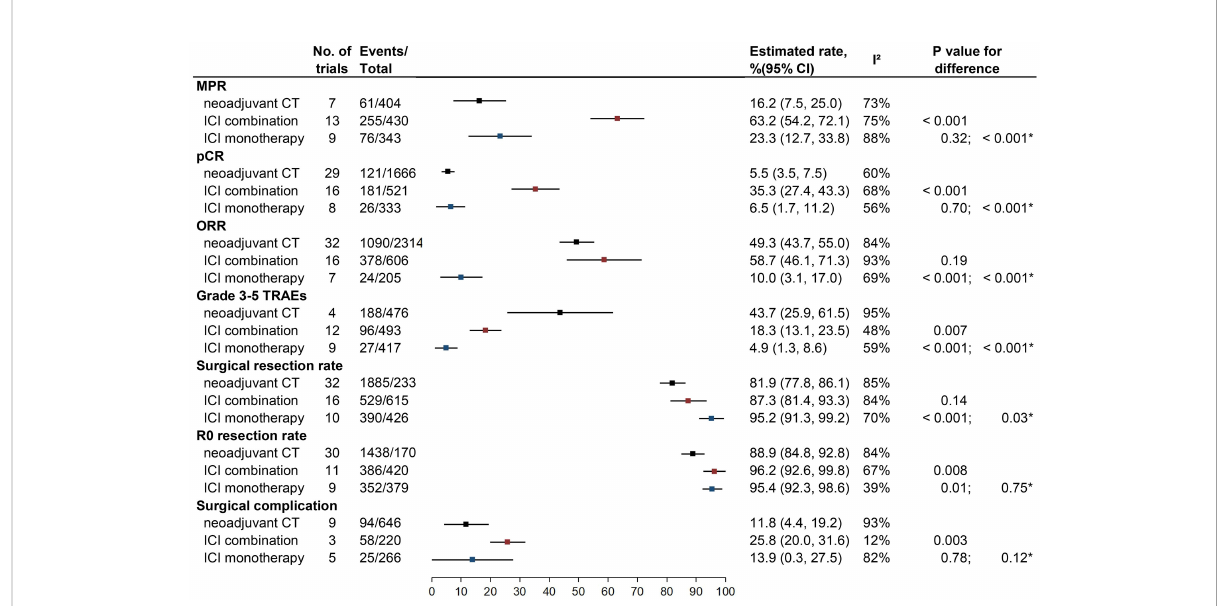
FIGURE 2 Outcomes of neoadjuvant CT vs. neoadjuvant ICI combination therapy vs. neoadjuvant ICI monotherapy. MPR, major pathologic response; pCR, pathological complete response; ORR, objective response rate; TRAEs, treatment-related adverse events; ICI, checkpoint inhibitor; CT,